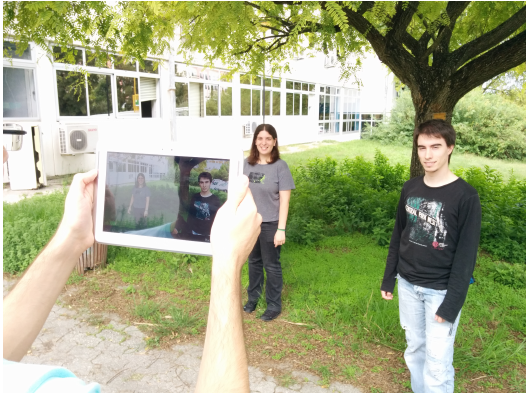
Figure 4: ARZombie game being played